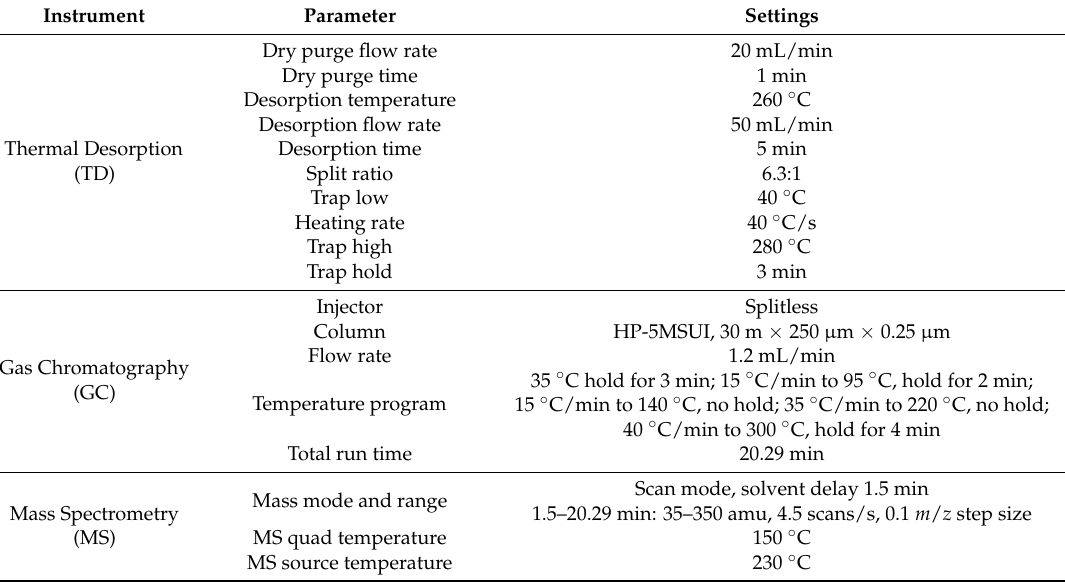
Table 1. Thermal desorption-gas chromatography/mass spectrometry (TD-GC/MS) conditions. Instrument Parameter